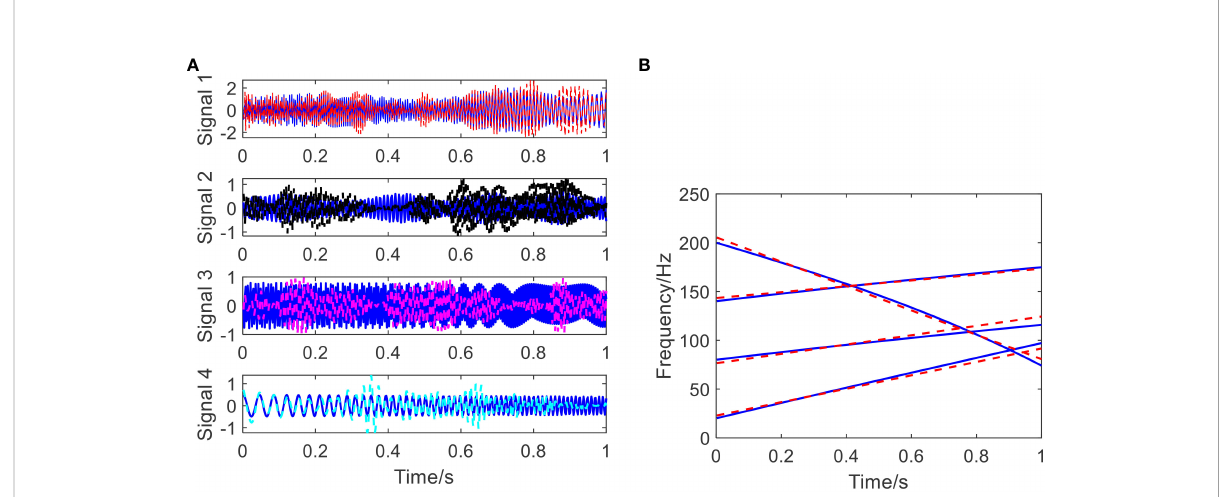
FIGURE 3 The estimated signal components and estimated time frequency plot using the proposed approach. (A) The estimated components (blue: true; red, black, carmine, and cyan: estimated ones); (B) The estimated time frequency plot (blue: true; red: